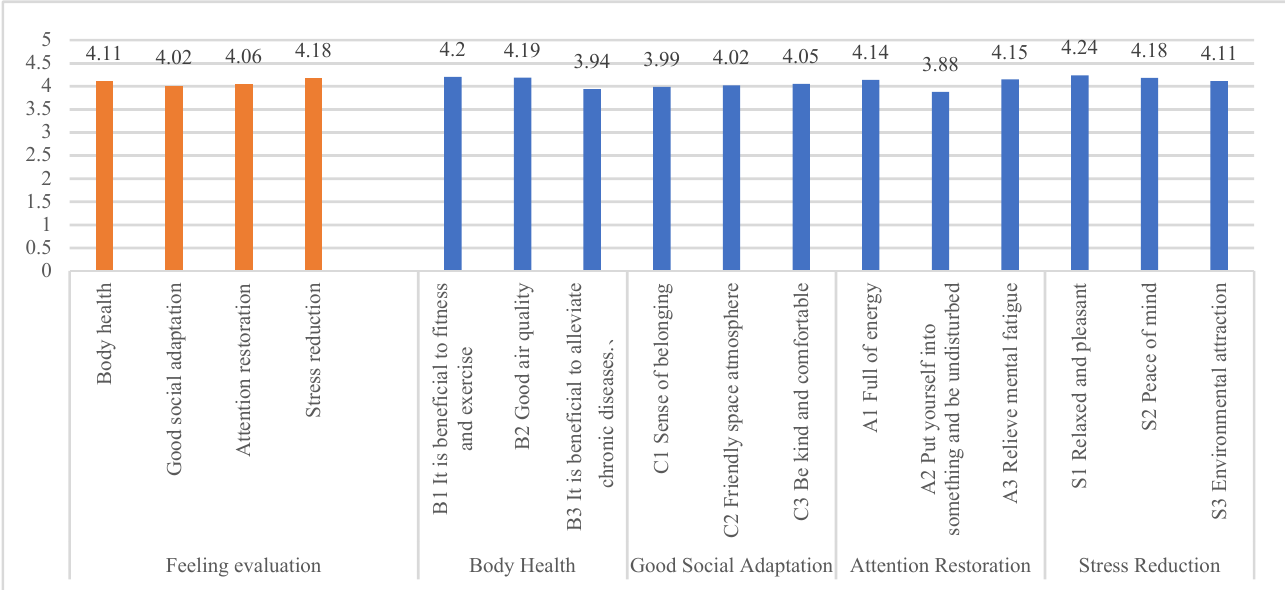
Figure 10. Results of user perception evaluation in community parks.